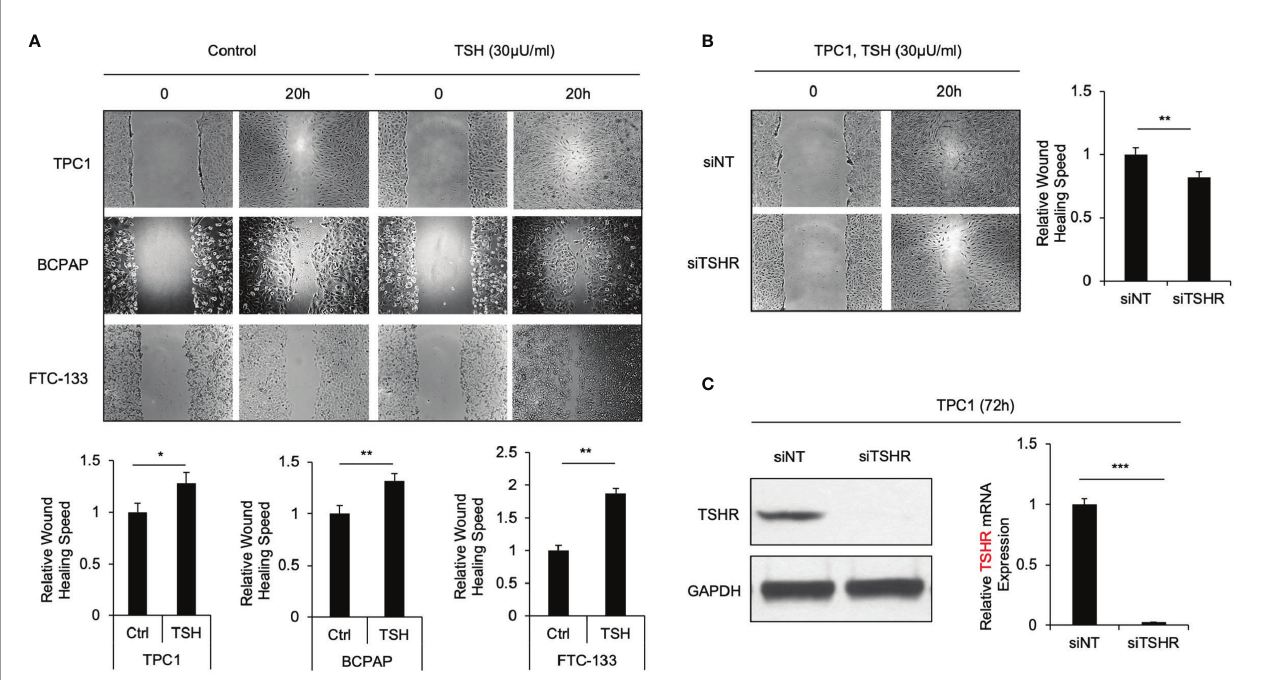
FIGURE 1 | TSH-TSHR increase cell migration in thyroid cancer cells. (A) Wound-healing assay for TPC1, BCPAP and FTC-133 cells treated with 30 m U/ml TSH or control with HBSS. Pictures were taken at 0 and 20 hours after wound scratch. The bar graphs represent relative wound healing rate of TPC1, BCPAP and FTC-133 cells with TSH treatment normalized with controls. Data represent means ± SEM of 3 independent experiments. (B) Wound-healing assay for TPC1 cells incubated with 30 m U/mL TSH transiently transfected with non-targeting siRNA control (siNT) or TSHR siRNA (siTSHR). Wound scratch was performed at 72 hours after siRNA transfection, and then picture was taken at that point and 20 hours later. Bar graph represents relative wound healing rate of TPC1 after siTSHR knockdown normalized with control. Data represent means ± SEM of 3 independent experiments. (C) Immunoblots of TSHR and GAPDH in TPC1 cells transfected with siNT and siTSHR for 72 hours. Bar charts represent relative TSHR mRNA levels in TPC1 cells transfected with siNT and siTSHR for 72 hours. Data represent means ± SEM of 3 independent experiments. * P < 0.05, ** P < 0.01, *** P <